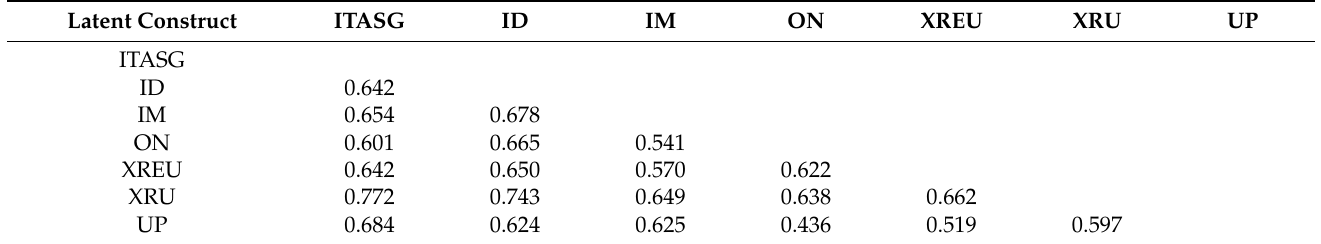
Table 5. Hetero-Trait-Mono-Trait